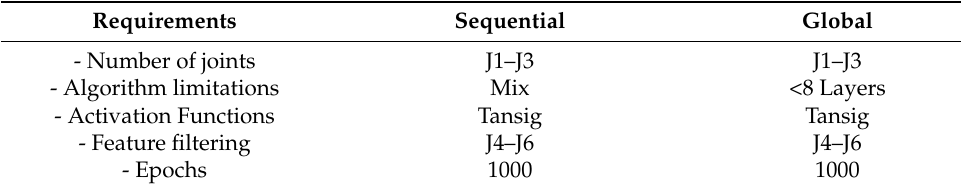
Figure 5. Workspace for the IRB140, J4—blue; J3—red; J2—black. Table 4. GA/ANN optimization inputs for